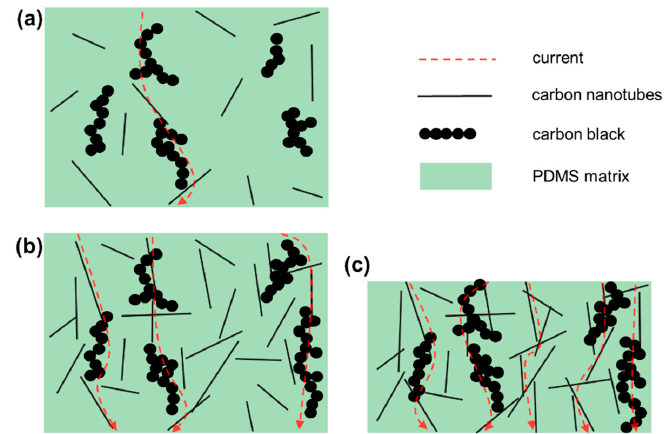
Figure 2. Schematic diagram of nanomaterial distribution in a polydimethylsiloxane (PDMS) polymer matrix. ( a ) Conductive networks in the nanocomposite at a low filling concentration; ( b ) conductive networks in the nanocomposite at a high filling concentration; ( c ) conductive networks in a high filling concentration nanocomposite under compressive